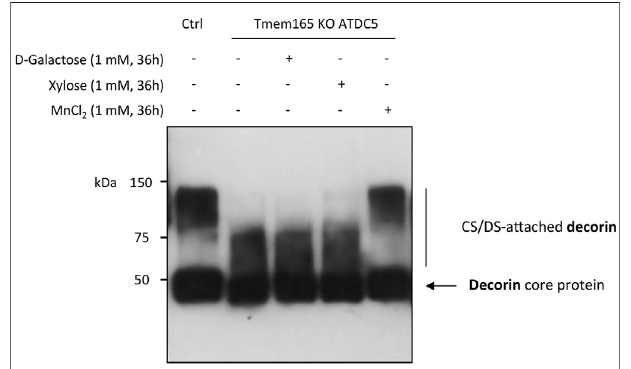
FIGURE 5 | Manganese but not galactose or xylose supplementation rescues GAG elongation in Tmem165 KO ATDC5 cells. Wild-type (Ctrl) and TMEM165-knockout mouse ATDC5 cells were transfected with an expression vector coding for decorin and cultured in the presence or absence of D-galactose (1 mM), xylose (1 mM) or MnCl 2 (1 µM). The electrophoretic migration pro fi les of decorin secreted in culture medium were then analyzed by western-blotting. The positions of decorin without (core protein) or with CS/DS chains are indicated on the right side of the western-blot.